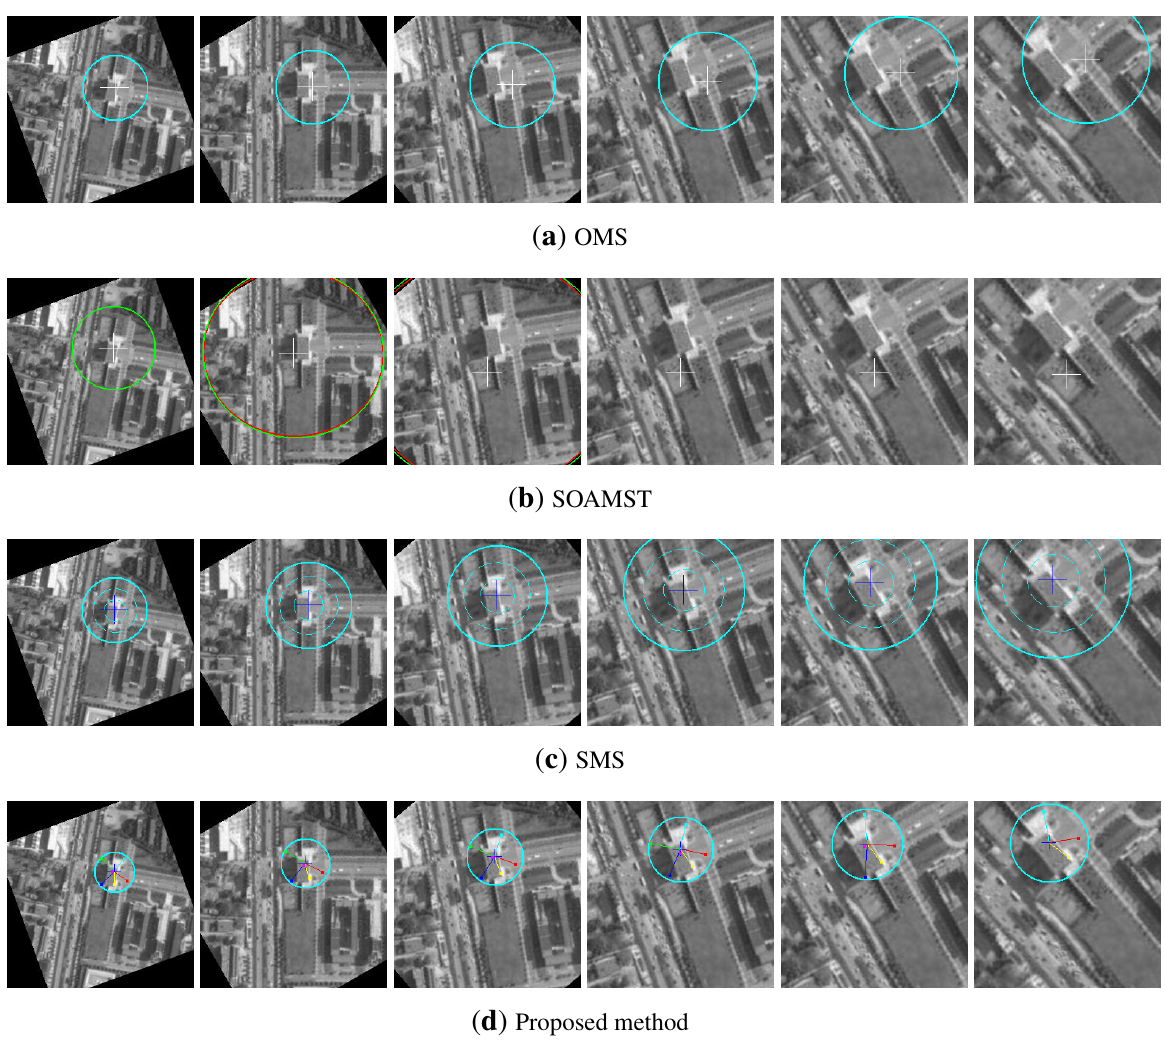
Figure 4. Comparison of the three tracking methods on the first video. ( a ) tracking frames of OMS, the circles denote the real-time kernel radius; ( b ) tracking frames of SOAMST; ( c ) tracking frames of SMS; ( d ) tracking frames of #20 , . . . , #70 using our method, where each tracker is marked by one color and their voted target center is marked by “ + ”, and the circles denote the real-time kernel